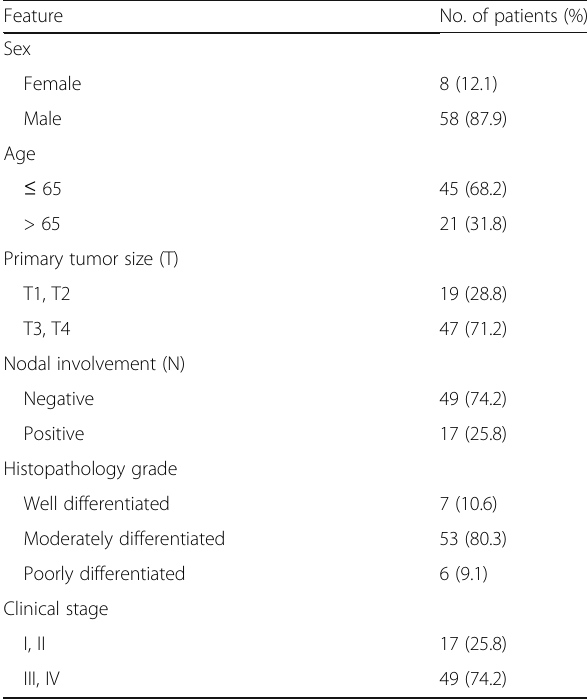
Table 1 Characterization of the patients with laryngeal